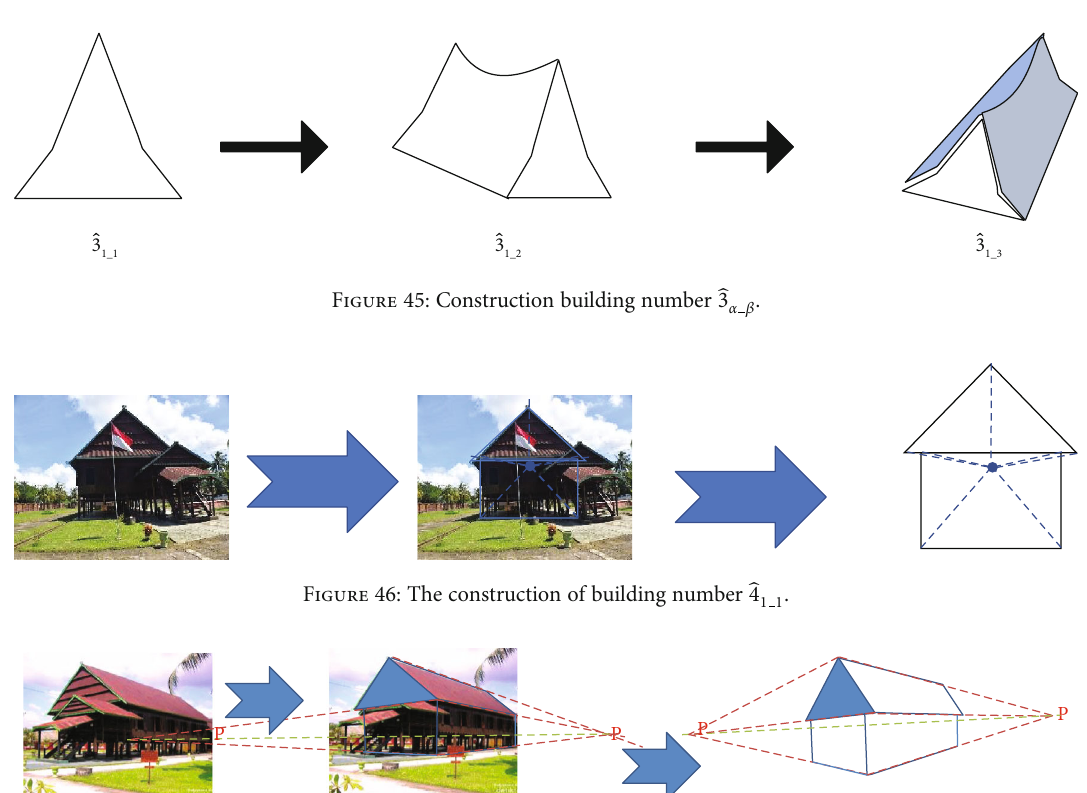
Figure 47: The construction of building number ̂ 4